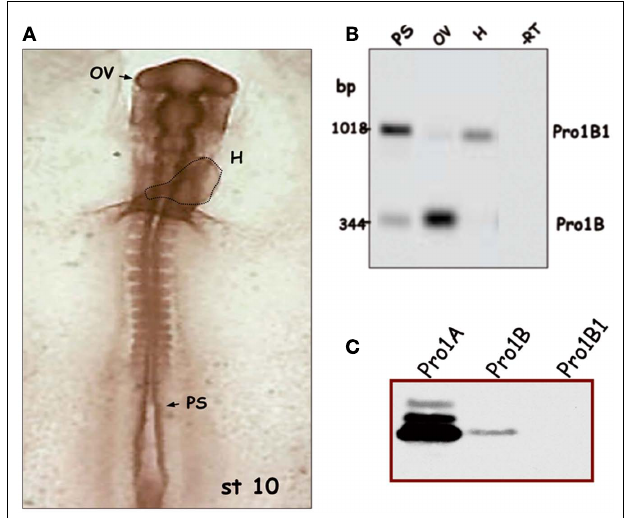
FIGURE 3 | Regulated splicing pattern of embryonic proinsulin mRNA. (A) Stage 10 chick embryo (approximately 36h of development) with the dotted line indicating the embryonic heart (H); the presomitic region (PS), and optic vesicle (OV) are depicted. (B) Proinsulin reverse transcription-PCR followed by Southern blot of RNA from different regions of stage 10 embryos. Intron 1 is retained in the Pro1B1 transcript, but spliced out in Pro1B.The latter form predominates in the OV (largely neuroepithelium at this stage) and is relatively less abundant in other embryonic regions. (C) Proinsulin expression in NIH3T3 cells transfected with the indicated construct. Modified from Mansilla et al.